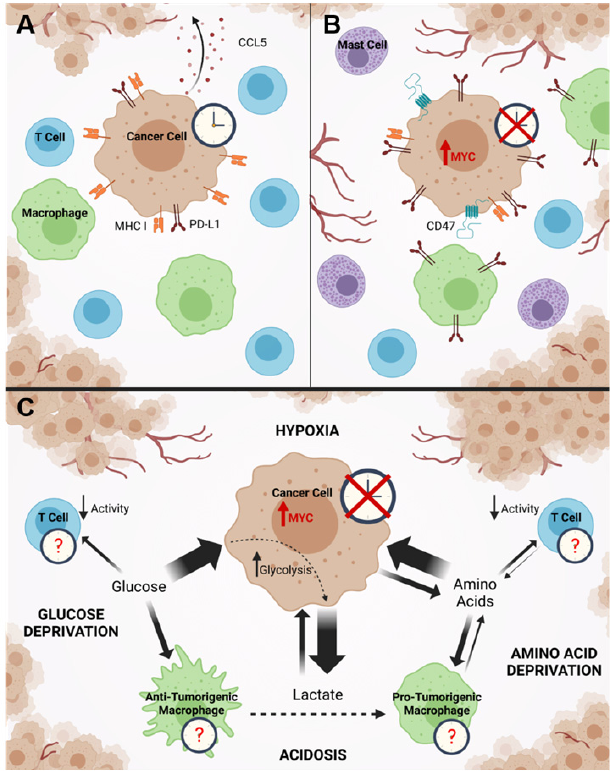
Figure 3. MYC drives changes in gene expression that can directly and indirectly alter the tumor immune microenvironment. ( A ). Expression of MHC I on cancer cells promotes tumor antigen-specific immune responses, while secretion of chemokines such as CCL5 mediates recruitment of immune cells to the tumor site. Low surface expression of PD-L1 within the tumor facilitates antitumor T cell activity, contributing to an immunogenic or immunologically “hot” tumor microenvironment. ( B ). MYC suppresses MHC I and upregulates PD-L1 on cancer cells, which work synergistically to suppress antitumor immune responses. MYC also suppresses CCL5 secretion, upregulates the “don’t eat me” signal CD47, and promotes recruitment of mast cells. Together, this leads to an altered composition of the tumor-immune infiltrate and skewing toward an immunosuppressive or immunologically “cold” tumor microenvironment. ( C ). MYC in cancer cells promotes cancer cell-intrinsic changes in metabolism, which can lead to changes in the availability of metabolic intermediates in the tumor microenvironment. Increased glucose and amino acid metabolism in MYC-overexpressing cancer cells drives increased uptake and subsequent depletion of these key metabolites within the immediate microenvironment. Deprived of glucose or certain amino acids, T cell activity is decreased. Simultaneously, acidosis due to increased lactate excretion polarizes tumor-associated macrophages toward a pro-tumorigenic phenotype. In conjunction with hypoxia often present within regions of solid tumors, these metabolically stressful conditions may foster an immunosuppressive microenvi- ronment whose effects on the molecular clock of infiltrating immune cells remains unknown. In each panel, dotted line indicates polarization toward a different phenotype. Line thickness corresponds to the relative magnitude of intake or output of metabolites by cell types. Created with BioRender.com, publication license acquired on